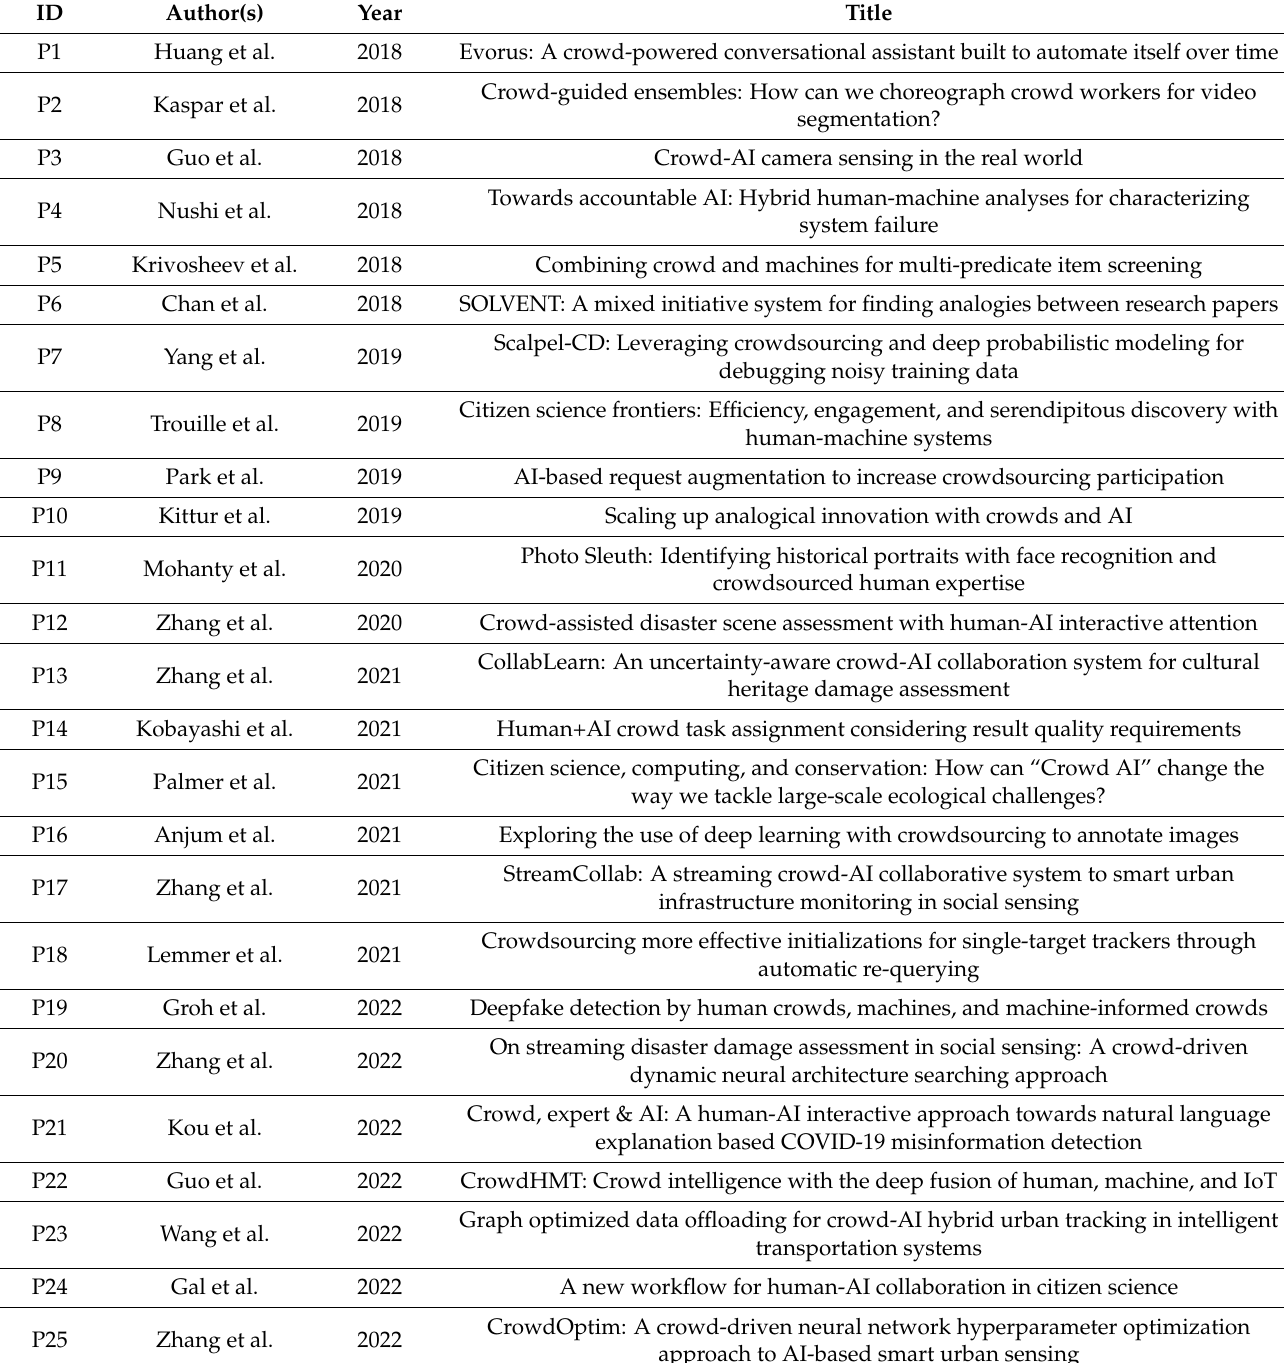
Table A1. List of primary studies included in the taxonomic validation